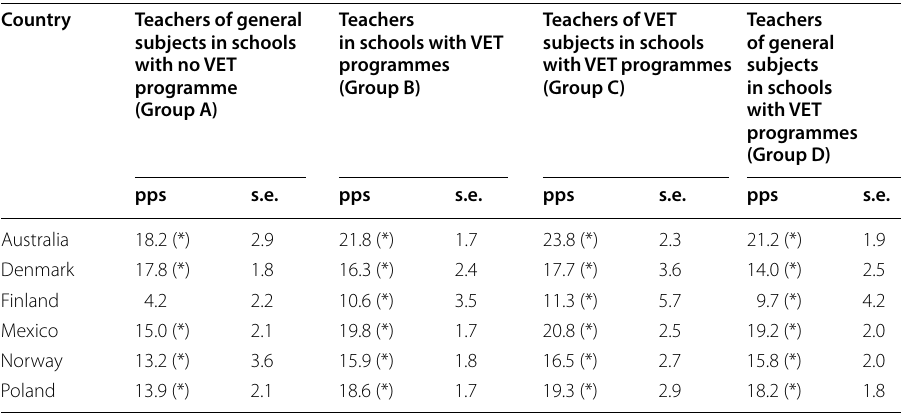
Table 3 Non participation in teachers’ professional development activities: differences between Italy and other countries, in percentage points (pps) and standard error of the differences (s.e.), 2013 (Source: Author’s calculations based on OECD, TALIS 2013)